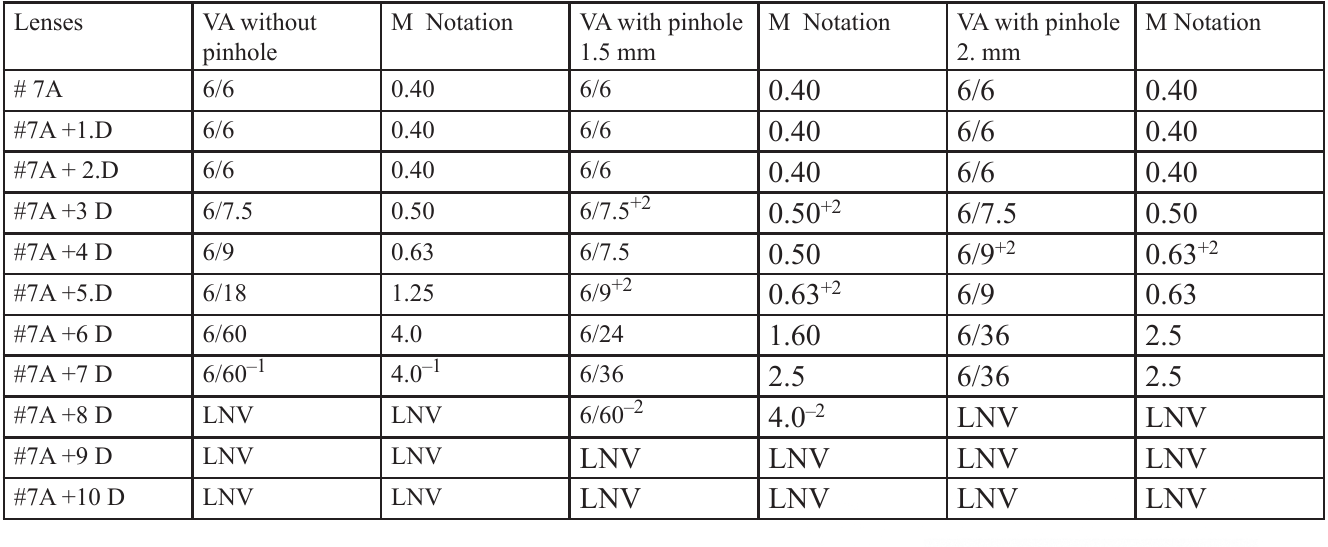
Table 2. Effect of positive lenses on VA for Subject 1 viewing a Lighthouse Near Acuity chart at 40 cm without a pinhole and through a pinhole with a 1.5 mm and 2 mm diameter respectively while the target was illuminated at 460 lux. (Under certain condi- tions the letters on the chart were not recognizable or visible and were recorded as LNV meaning Letters Not Visible.) Lenses VA